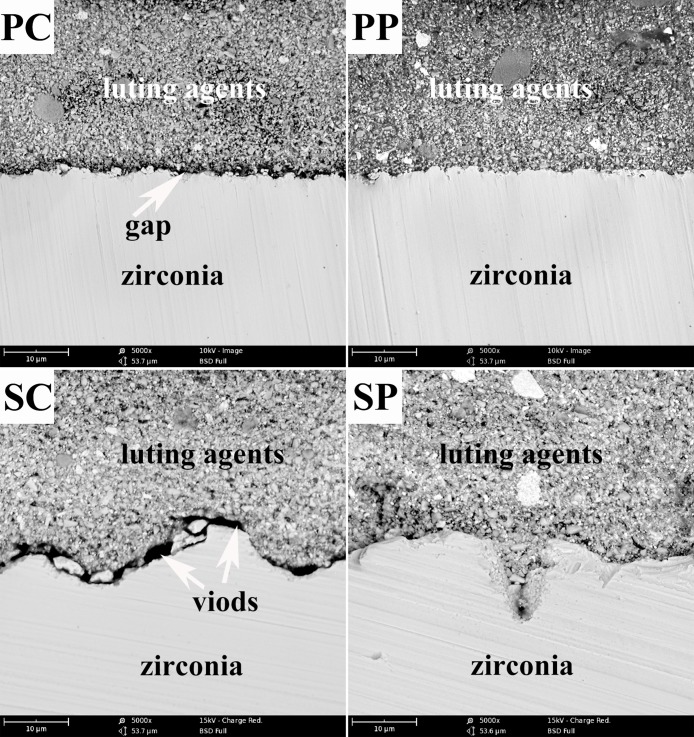
Representative SEM microphotographs of all groups (5000 ×).